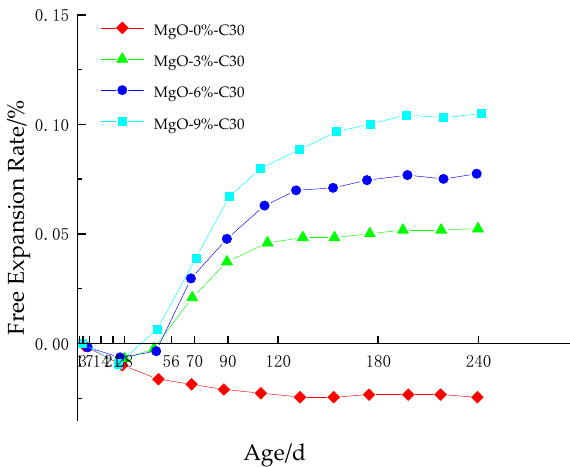
Figure 11. Free expansion value rate of C30 concrete under different magnesia contents.